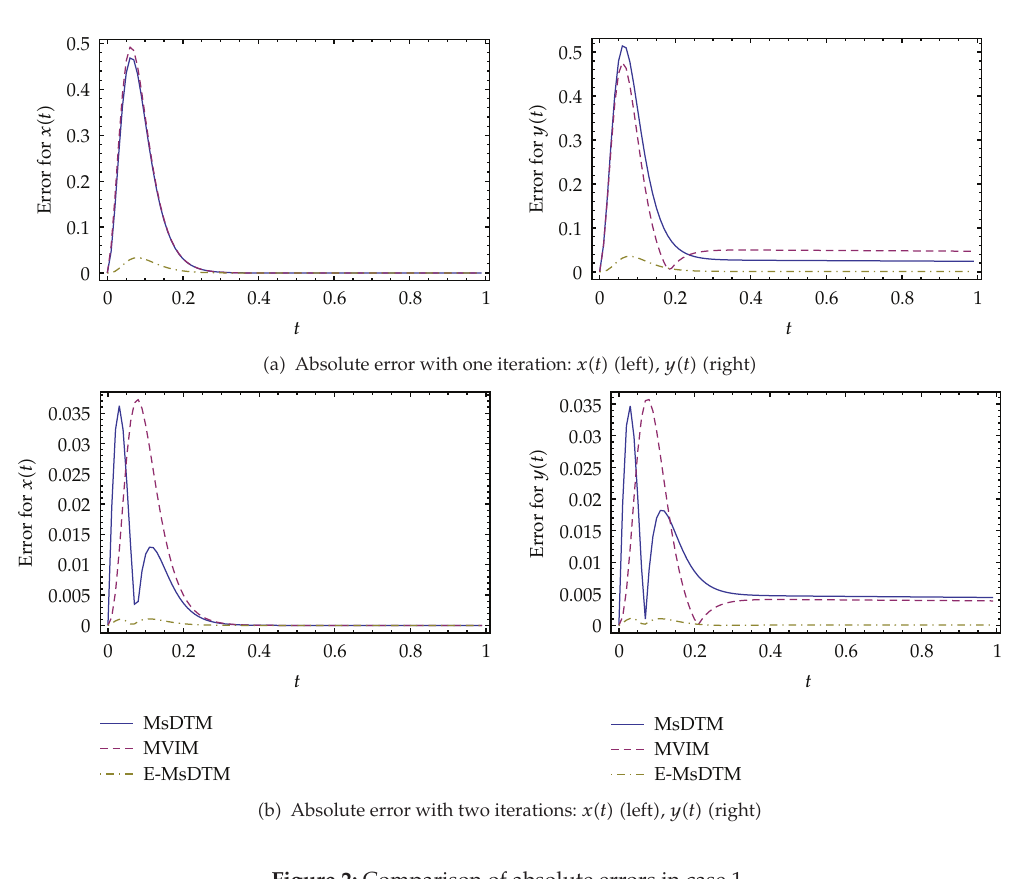
Figure 2: Comparison of absolute errors in case 1.